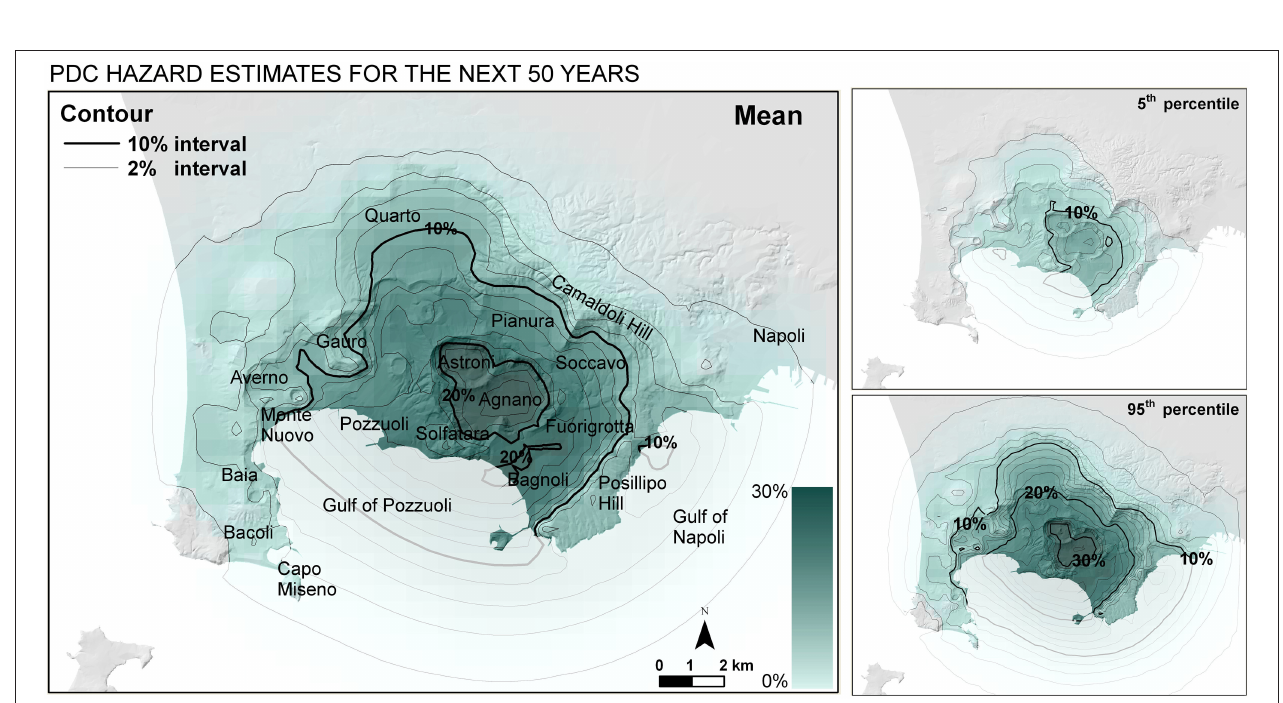
FIGURE 8 | Temporal PDC invasion hazard map based on the vent opening map and the areal size distributions displayed in Figure 3 , and temporal estimates assuming that in A.D. 1538 the volcano entered a new eruptive epoch. Contours and colors indicate the mean percentage probability of PDC invasion in the next 50 years—this includes the possibility of a sequence of multiple events in this time period. In the small boxes are included the 5th (top) and 95th (bottom) uncertainty bounds of the PDC invasion probability.